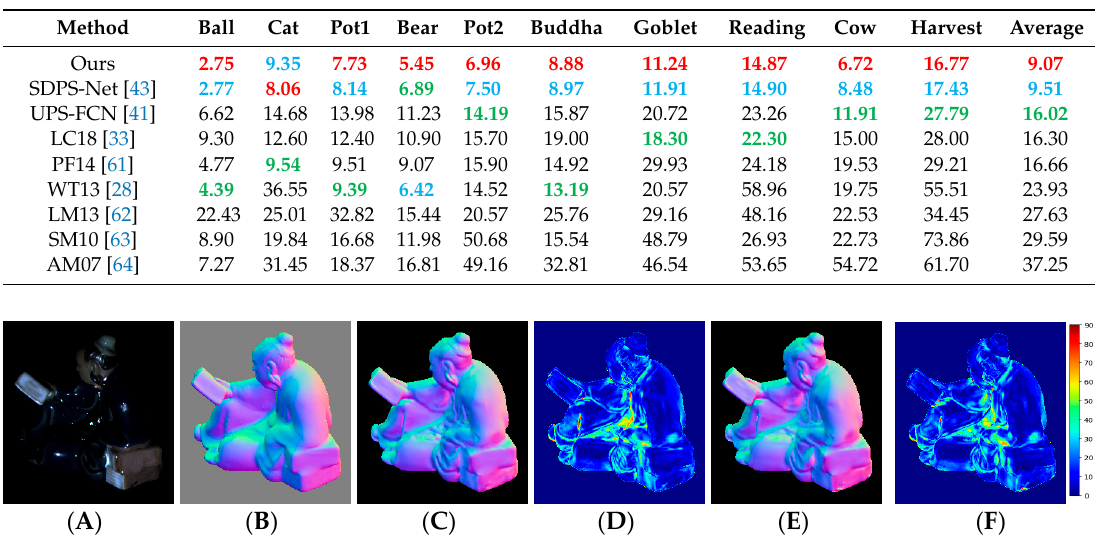
Figure 4. Visual quality comparisons on the Buddha object in the DiLiGent benchmark for the calibrated photometric stereo: ( A ) one image among 96 input images; ( B ) ground-truth surface normal map; ( C ) surface normal map estimated with PS-FCN; ( D ) angular error map for PS-FCN; ( E ) surface normal map estimated with the proposed method; ( F ) angular error map for the Table 2. Accuracy comparison for the DiLiGenT benchmark in the surface normals estimation of proposed method. uncalibrated photometric stereo methods. the value indicates the mean angular errors in degrees for estimated surface normals where red, blue, and green indicate the best, second-best, and third-best performances, respectively.